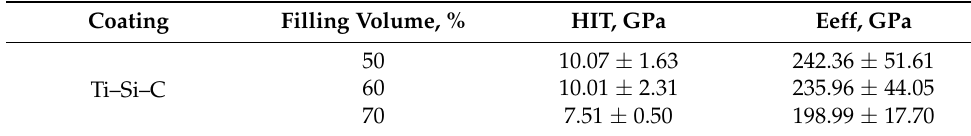
Table 1. Results of nano-indentation.